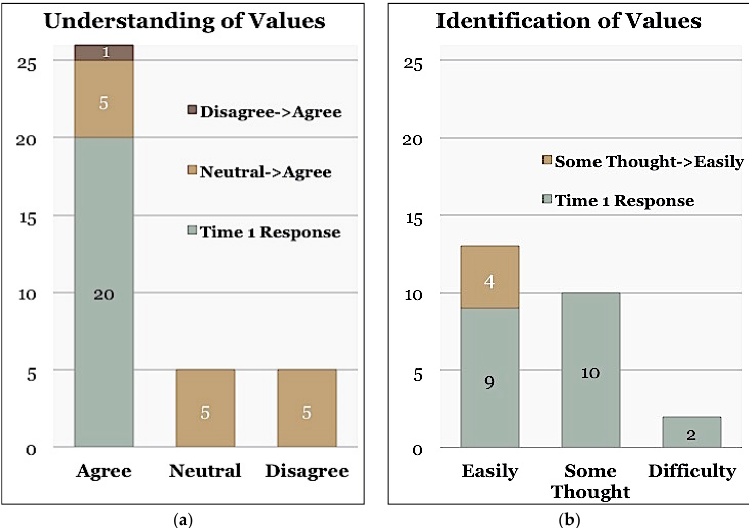
Figure 3. Primary class changes between Time 1 and Time 2. ( a ) Emerging adults in the primary class changed from two ‐ thirds agreeing that they understood their values to all agreeing with this. Twenty percent (n = 5) moved from formerly neutral on this question to agreeing, and four percent (n = 1) changed from disagreeing to agreeing; ( b ) at Time 1, one ‐ third of the class said they could identify their values easily (n = 9), and 16 percent (n = 4) said they could do it with some thought at Time 1 said at Time 2 that they could identify their values easily. The remaining half remained stable in their responses, with 40 percent with some thought (n = 10), and 8 percent with difficulty (n = 2).